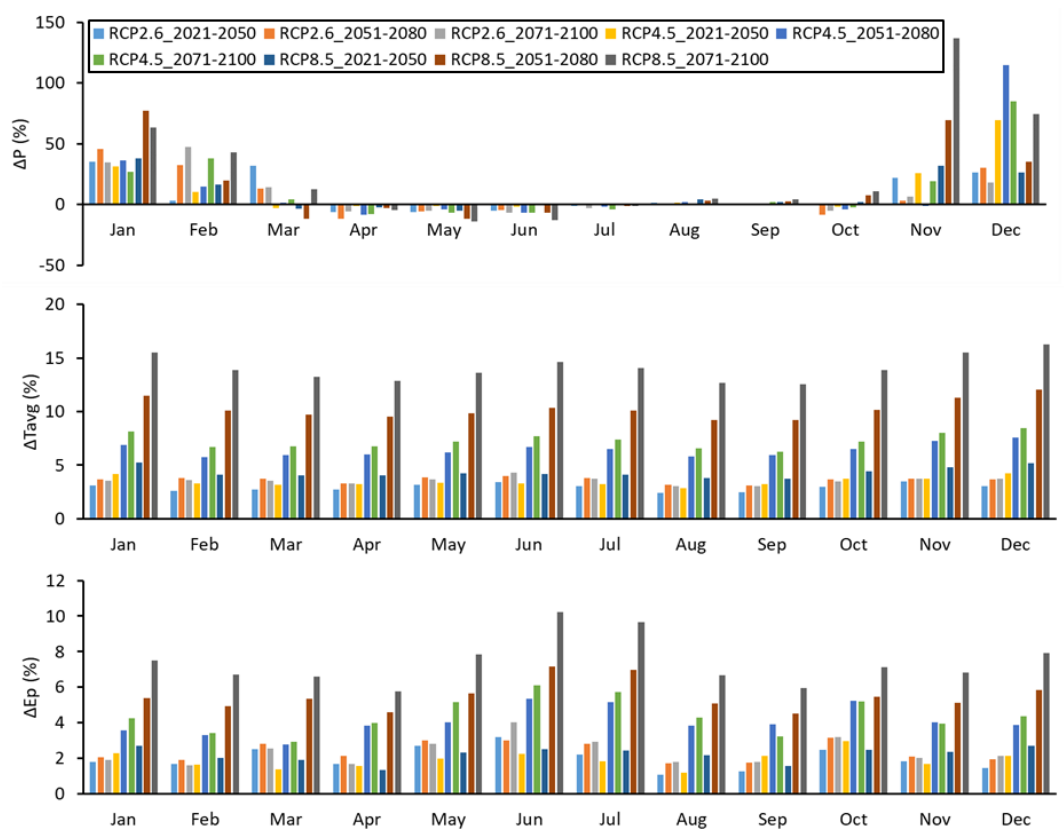
Figure 6. Mean seasonal changes (%) in climatic variables ( P , T avg , and E p ) over the future periods (2021–2050, 2051–2080, and 2071– 2100) relative to the historical period (1991–2020).